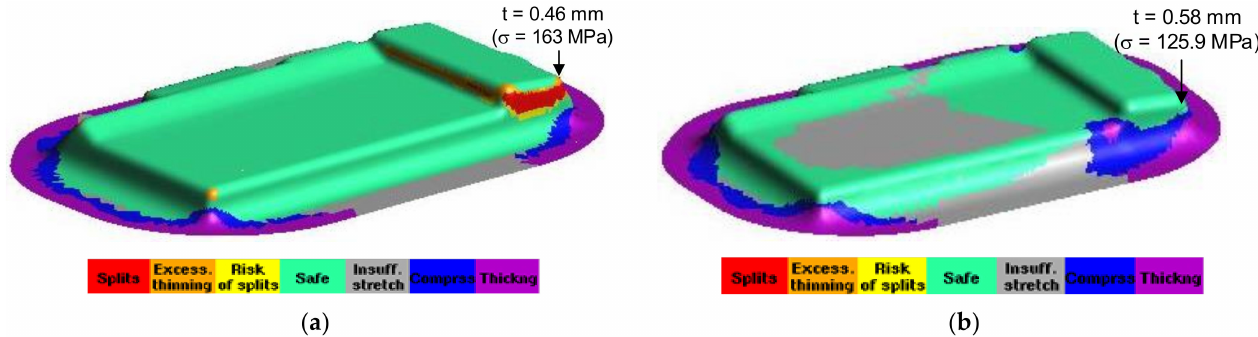
Figure 17. The numerical forming results. ( a ) Case I with R D = 5 mm, R D1 = 2 mm and R P = 0.8 mm; ( b ) Case II with R D = 8 mm, R D1 = 4 mm and R P = 2 mm.